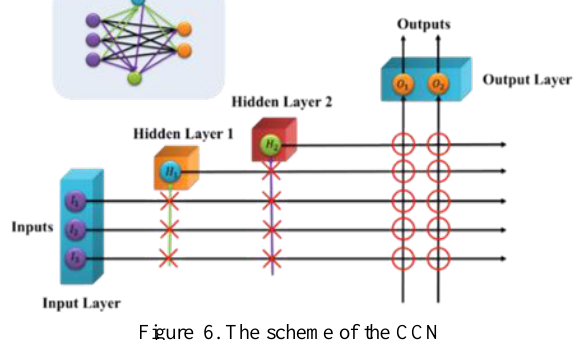
Figure 6. The scheme of the CCN